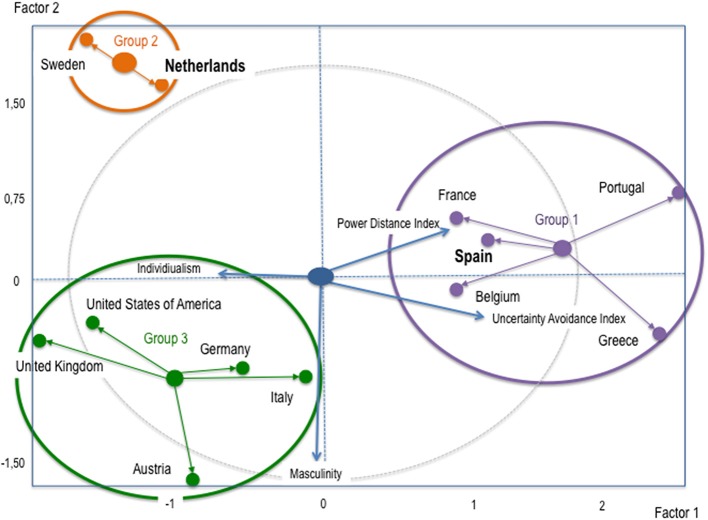
Positioning countries by cultural dimensions. Source: Grande (2004, p. 109).